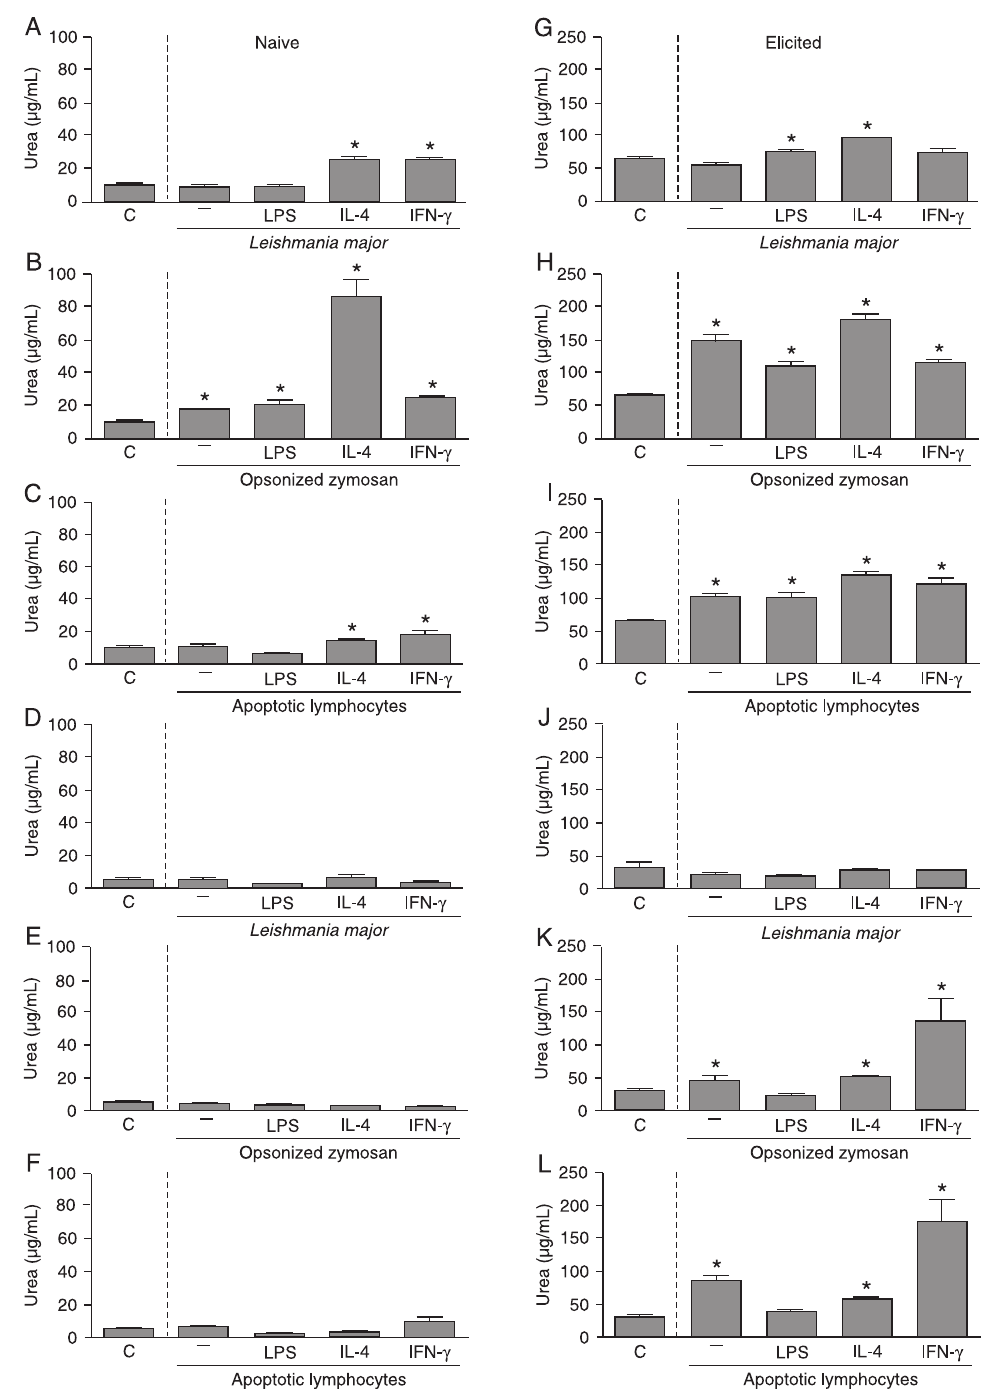
Figure 3. Effects of phagocytosis on arginase activity in peritoneal macrophages of mice (N = 6 per group). A , B , C , Naive BALB/c mice; D , E , F , naive C57BL/6 mice; G , H , I , elicited BALB/c mice; J , K , L , elicited C57BL/6 mice. Adherent peritoneal cells were incu- bated with lipopolysaccharide (LPS; 100 ng/mL), interleukin-4 (IL-4; 4 IU/mL) or interferon-γ (IFN-γ, 5 IU/mL) for 18 h, at 37°C, in 5% CO 2 . Cells of the control groups (C) were incubated in the absence of stimuli. After removal of the stimuli, cells were incubated with Leishmania major (3 x 10 6 cells/mL), C3b opsonized zymosan (5 x 10 6 yeasts/mL) or apoptotic lymphocytes (5 x 10 6 cells/mL) for 3 h. Particles were then removed by washing, and the plates were re-incubated for 48 h. Arginase activity was determined in cell lysates on the basis of the amount of urea produced from L-arginine. All studies were conducted in triplicate. Bars indicate the means ± SEM of urea levels obtained in three independent experiments. *P ≤ 0.05 compared to control (Student t